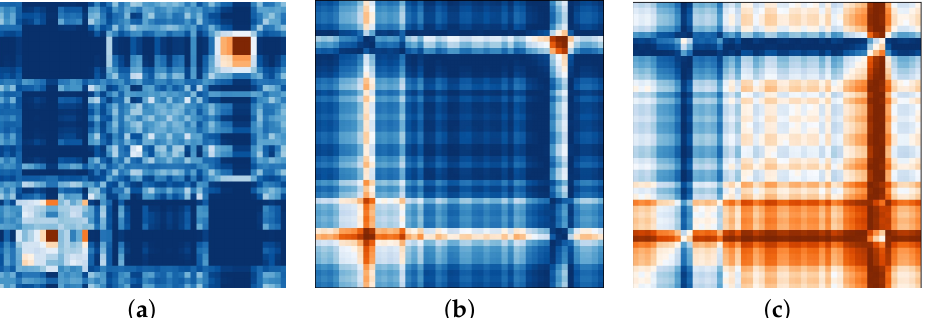
Figure 1. Implicit features: the three images that are generated to represent the X-coordinates of the right eye in one trial with externally directed attention. ( a ) Markov Transition Field (MTF). ( b ) Gramian Angular Summation Field (GASF). ( c ) Gramian Angular Difference Field